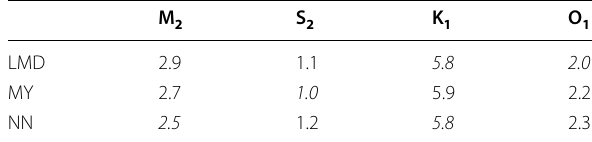
Table 7 RMS differences between the model estimates and observations for the major axes of the tidal ellipses for four constituents, M , S , K , and O , for the three 2 2 1 1 different vertical mixing parameterizations ~ 35% down = Italic numbers indicate the lowest rms